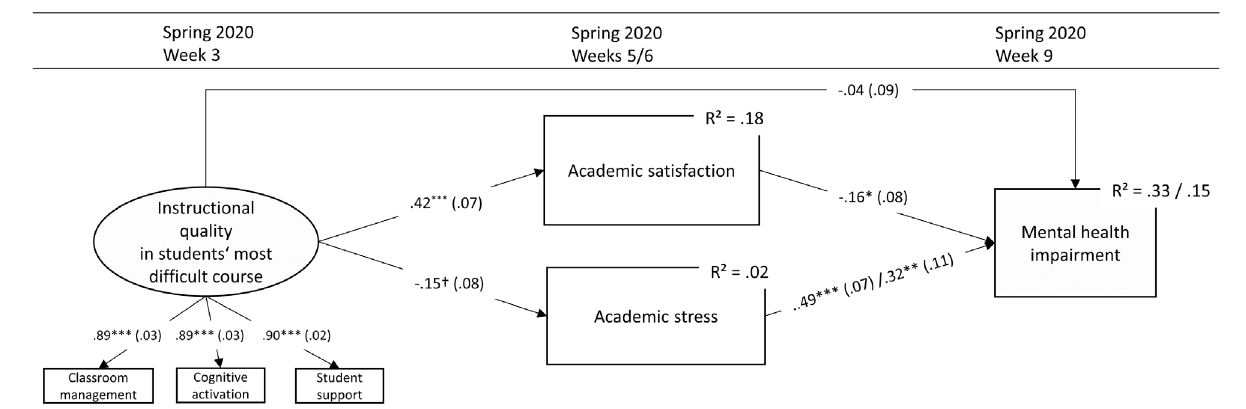
FIGURE 2 | Associations between Instructional Quality in Students ’ most Dif fi cult Course, Academic Stress, Satisfaction and Mental Health Impairment across Gender (Model A.1). Reported are standardized effects. Gender speci fi c effects for female ( n (cid:1) 137) and male students ( n (cid:1) 62) are reported if the Wald χ 2 -test indicated